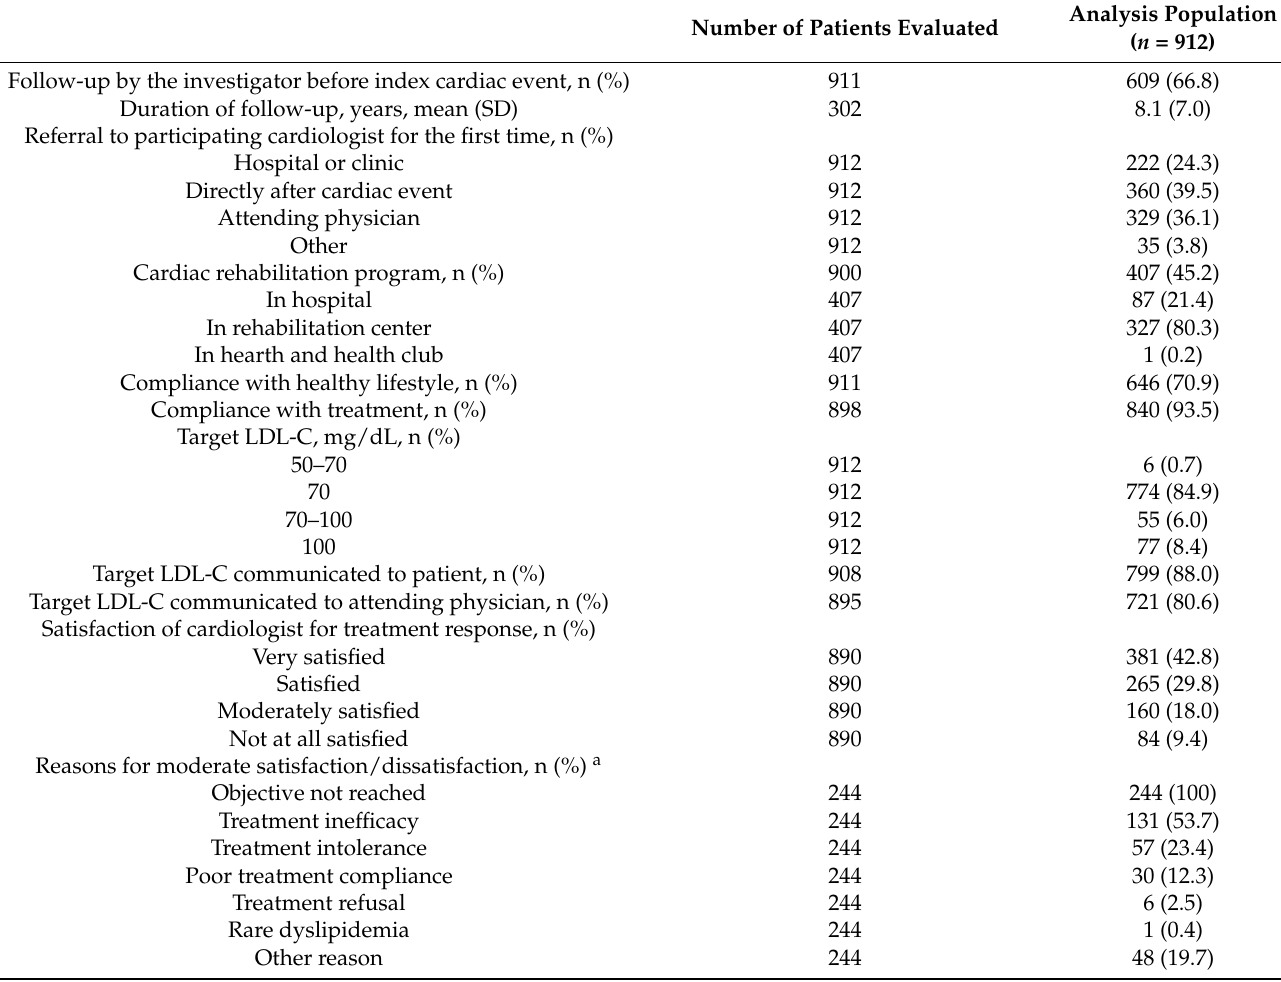
Table 4. Patient care after index cardiac event and LDL-C